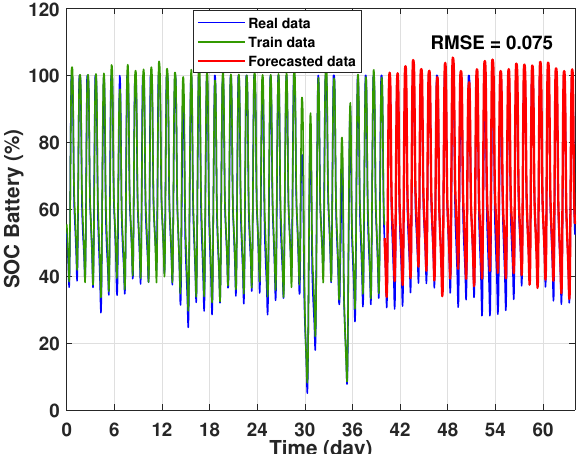
Figure 29. Battery SOC forecasting results over 25 days.